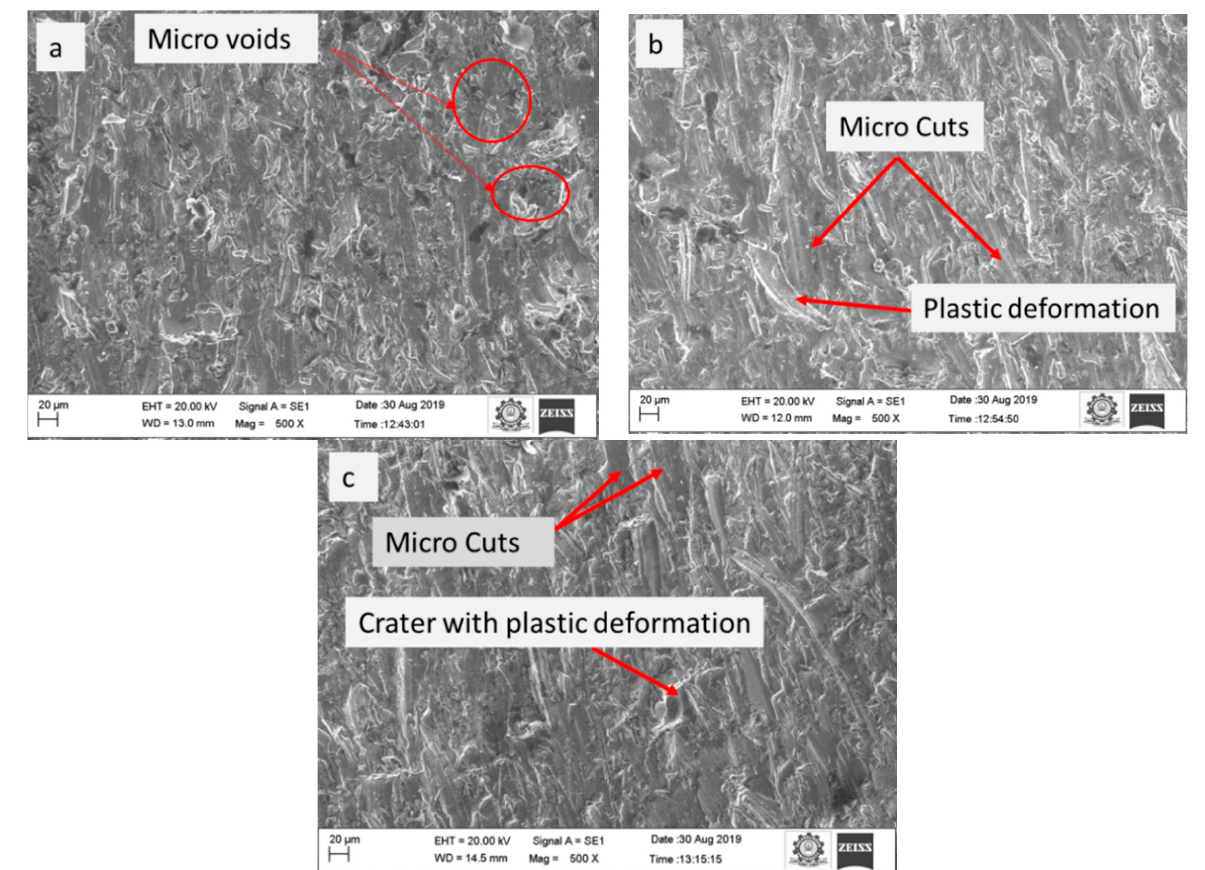
Figure 4. The surface morphology of the machined samples: ( a ) 5 mm/min, ( b ) 10 mm/min, and ( c ) 15 mm/min.